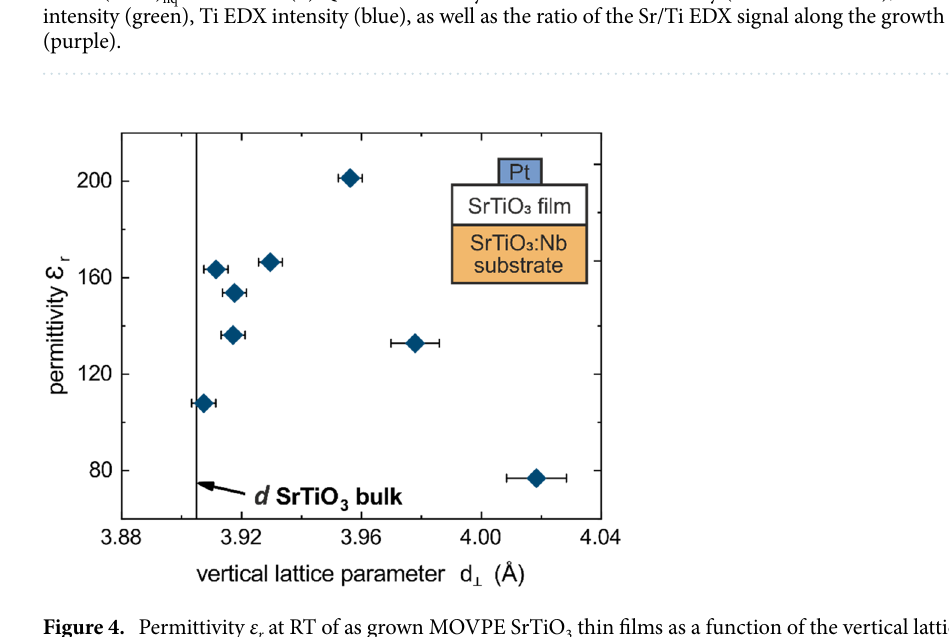
Figure 4. Permittivity ε r at RT of as grown MOVPE SrTiO 3 thin films as a function of the vertical lattice parameter d ⊥ . Inset figure shows the MOS-structure used for this measurement composed of SrTiO 3 :Nb, MOVPE SrTiO 3 thin film and Pt top contact. Error bars of the permittivity measurement are within the symbol size and results mainly from the uncertainties in contact